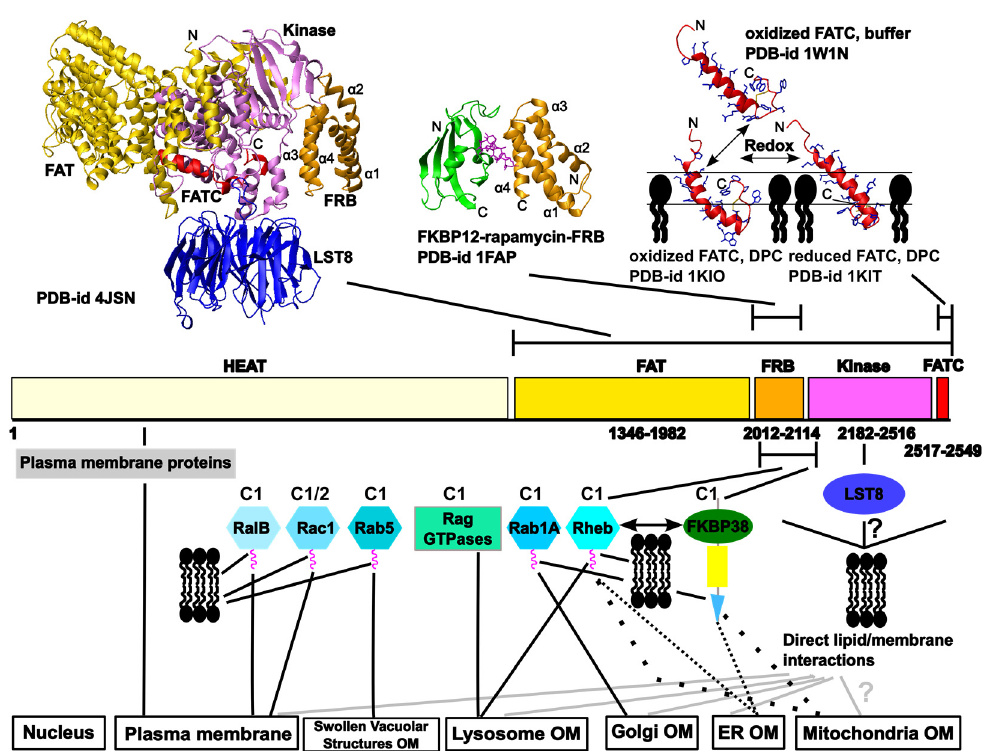
Figure 3. Overview of structural data for TOR and localization information data available for mTOR. Human TOR is 2549 residues long. Details about the domain structure are given in Figure 2a and the main text. The top panel shows the crystal structures of mTOR lacking the HEAT repeat region in complex with LST8 (blue) [50], the FRB domain in complex with rapamycin (magenta) and FKBP12 (FK506-binding protein of 12 kDa, green) [59], and the NMR structures of the oxidized FATC domain in the free [60] vs. oxidized and reduced forms in the DPC micelle immersed states [61]; the respective PDB-ids (protein databank identification numbers, [62]) are indicated. The color coding of the TOR domains is the same as in the domain representation below. Below the domain structure, interaction partners that have been [56] suggested to play a role in TOR membrane localization or direct lipid/membrane interactions by TOR domains and the cellular compartments mTOR has localized at are listed. More details can be found in the main text. All structure pictures were generated with the software Molmol [63]. C1 and C2 above the schematic illustrations of some TOR regulatory proteins indicate with which TOR complex they